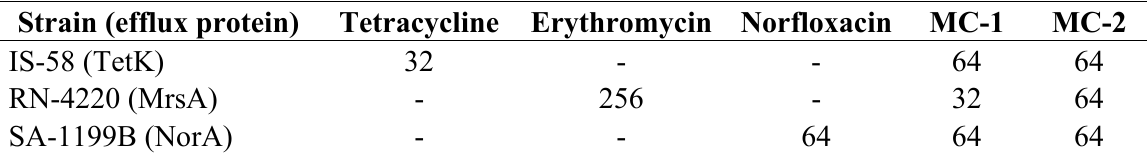
Table 1. MIC values (µg/mL) of test strains for antibiotics and hydrochloride of mesoionic